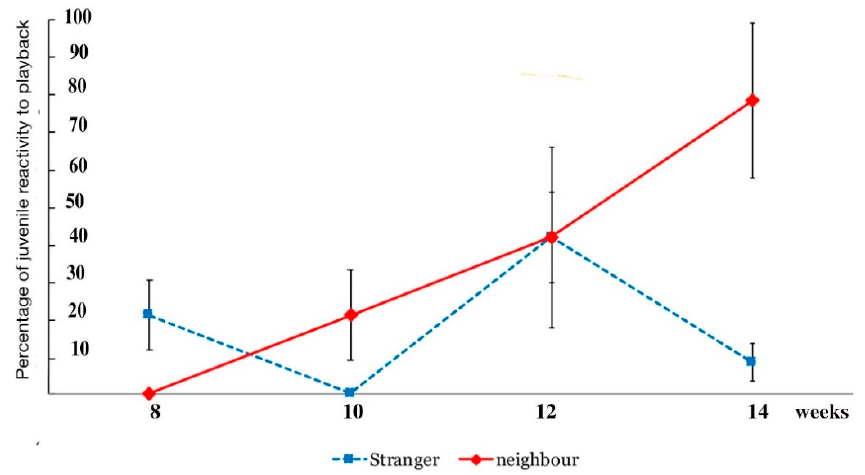
Figure 14. Juveniles responding to playback experiments from weeks 8 to 14 post fledging. The lines indicate the percentage of responses to playback (pen and paper scoring of attentive behaviour and referring to adults as itemised in the Materials and Methods Section). As the Figure shows, the continuous line shows the increasing reactivity of juveniles to playbacks of neighbours but not to strangers. This reactivity is expressed in vigilance behaviour, in looking towards adults or even walking or running towards adults. Prior to week 8, there were no behavioural responses recorded in juveniles while, by the 12th, week 40 percent of playback yielded a noticeable response, rising to 70 percent by week 14 [48], while the stranger calls created no such response and remained weak or non-existent (at chance level).